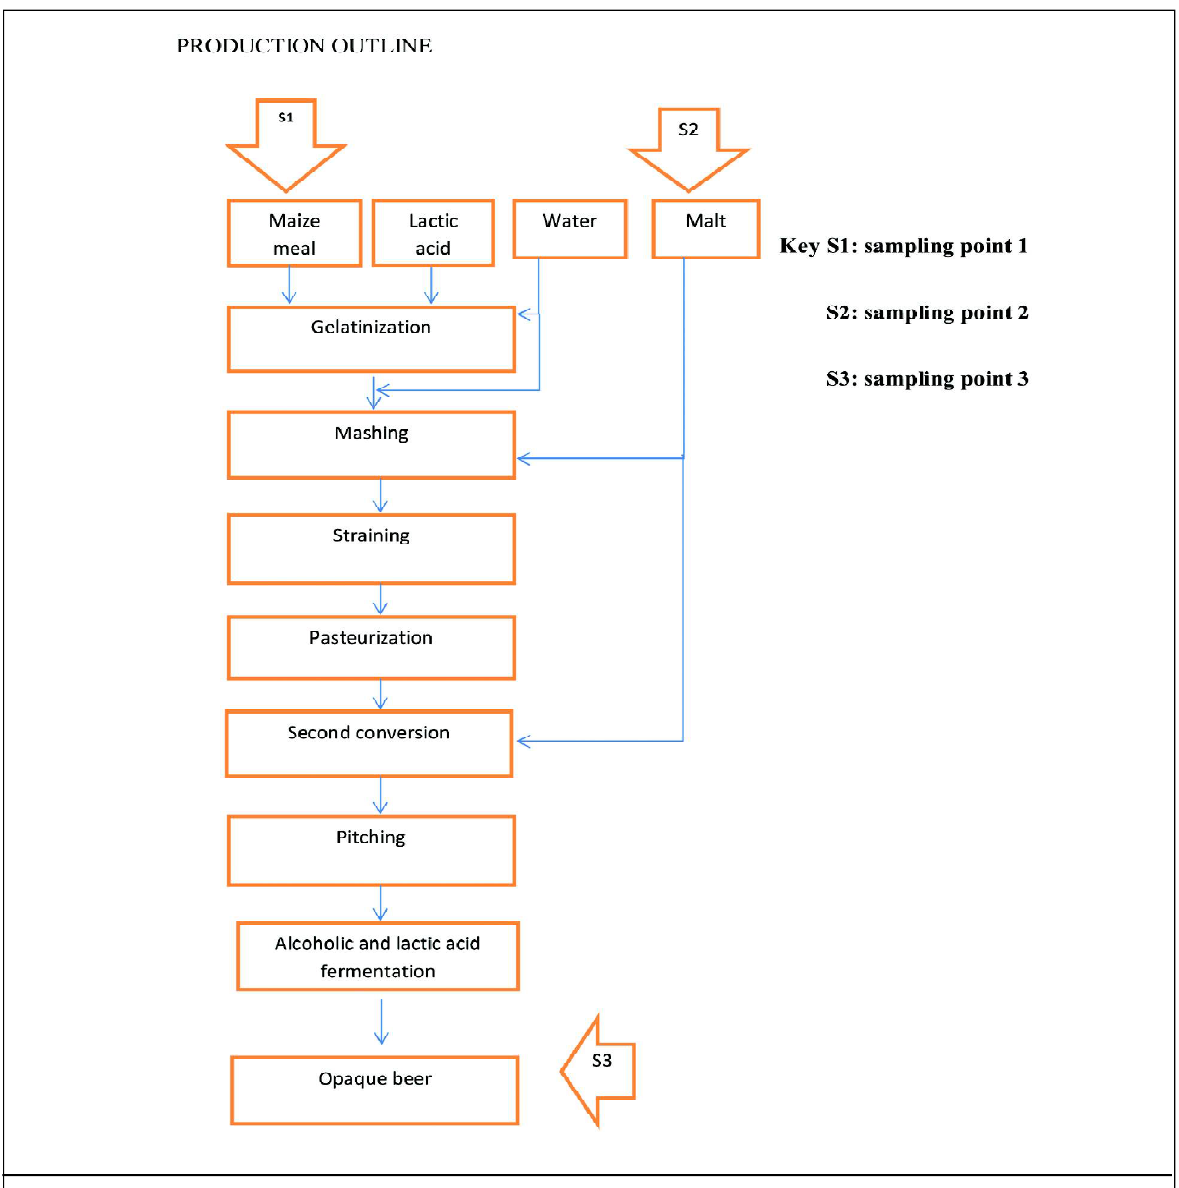
Figure 1: Opaque beer production